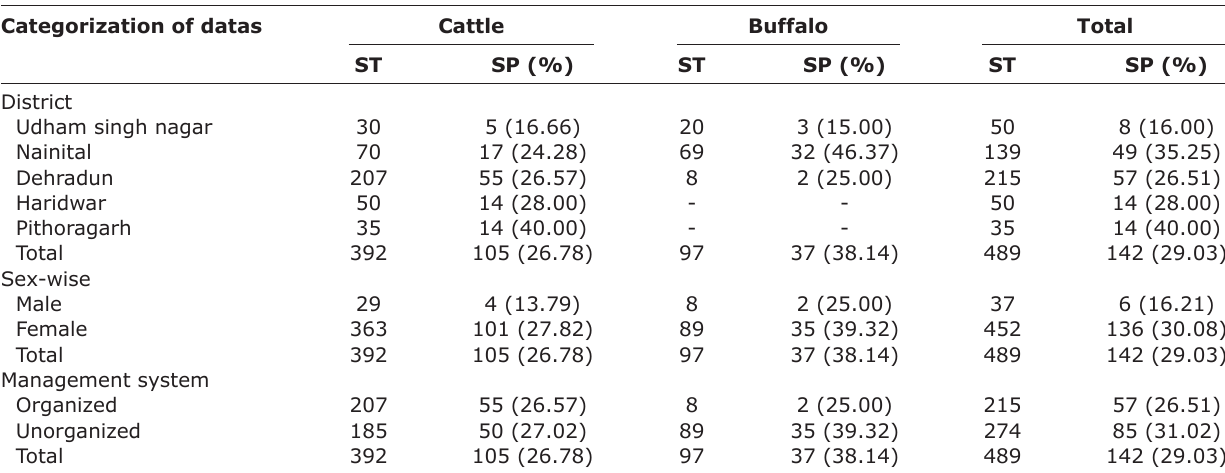
Table-1: Details of sample collected and seroprevalence. Categorization of